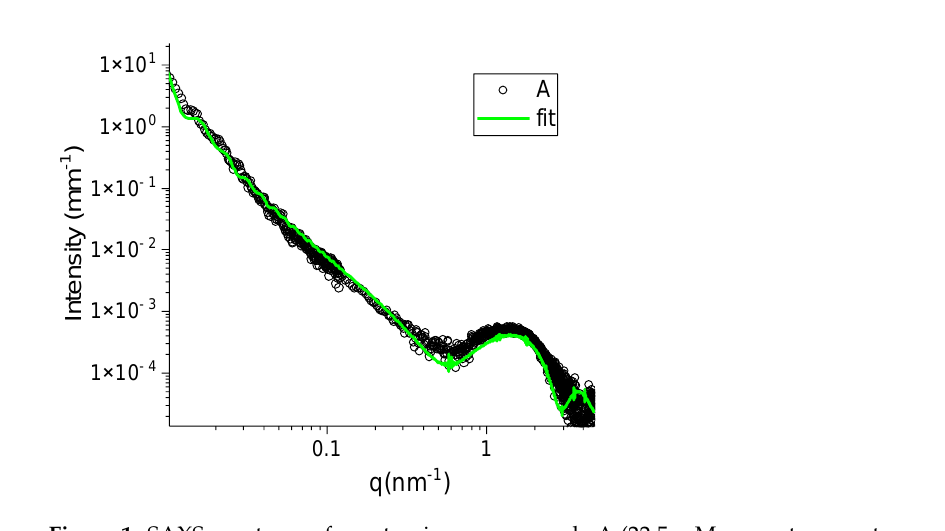
Table 3. Niosomal formulations characterization: summary of physicochemical features.